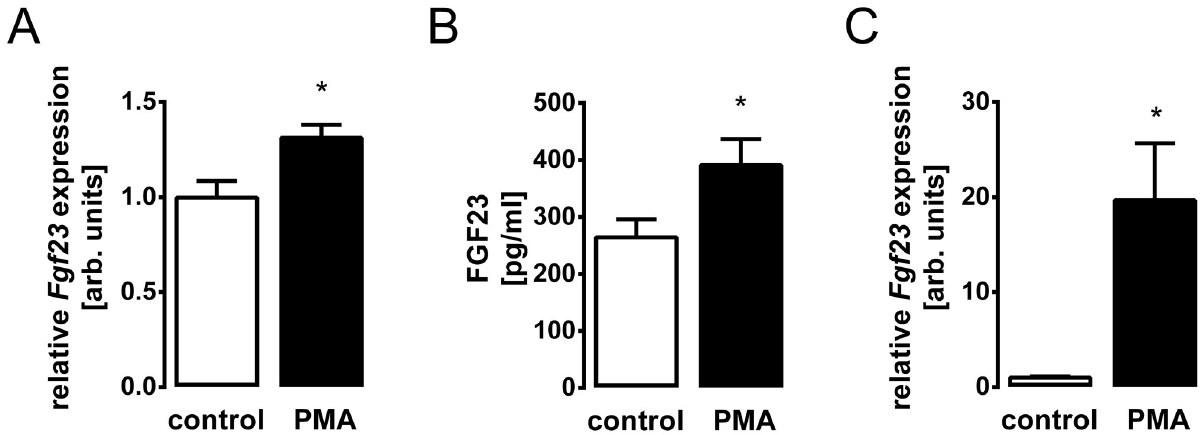
Fig 2. PKC activator PMA induces FGF23 production in UMR106 osteoblast-like cells and in IDG-SW3 osteocytes. Arithmetic means ± SEM (n = 6) of relative Fgf23 mRNA abundance normalized to Tbp in UMR106 osteoblast-like cells ( A ) or IDG-SW3 osteocytes ( C ), and FGF23 concentration in the cell culture supernatant of UMR106 cells ( B ) incubated without (white bars) or with (black bars) 0.1 μ M PKC activator PMA. � p < 0.05 indicates significant difference. arb.,